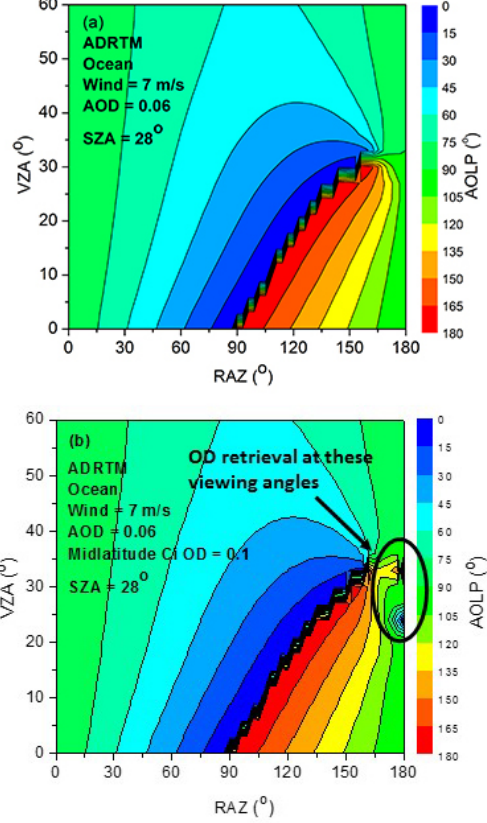
Figure 5. The modeled AOLP at a wavelength of 670nm as a function of viewing zenith angle (VZA) and relative azimuth an- gle (RAZ) from (a) the ADRTM for clear-sky oceans and (b) the ADRTM for oceans with a layer of super-thin clouds. In the mod- eling, the solar zenith angle (SZA) is 28 ◦ , ocean wind speed is 7ms − 1 , the sea-salt aerosol optical depth (AOD) is 0.06, and a layer of mid-latitude cirrus cloud with an optical depth of 0.1 is assumed with an altitude range of 7–8km. The difference of Fig. 5a and b shows the effect of super-thin clouds on the reflected sun- light’s AOLP. This figure is reproduced from Sun et al.